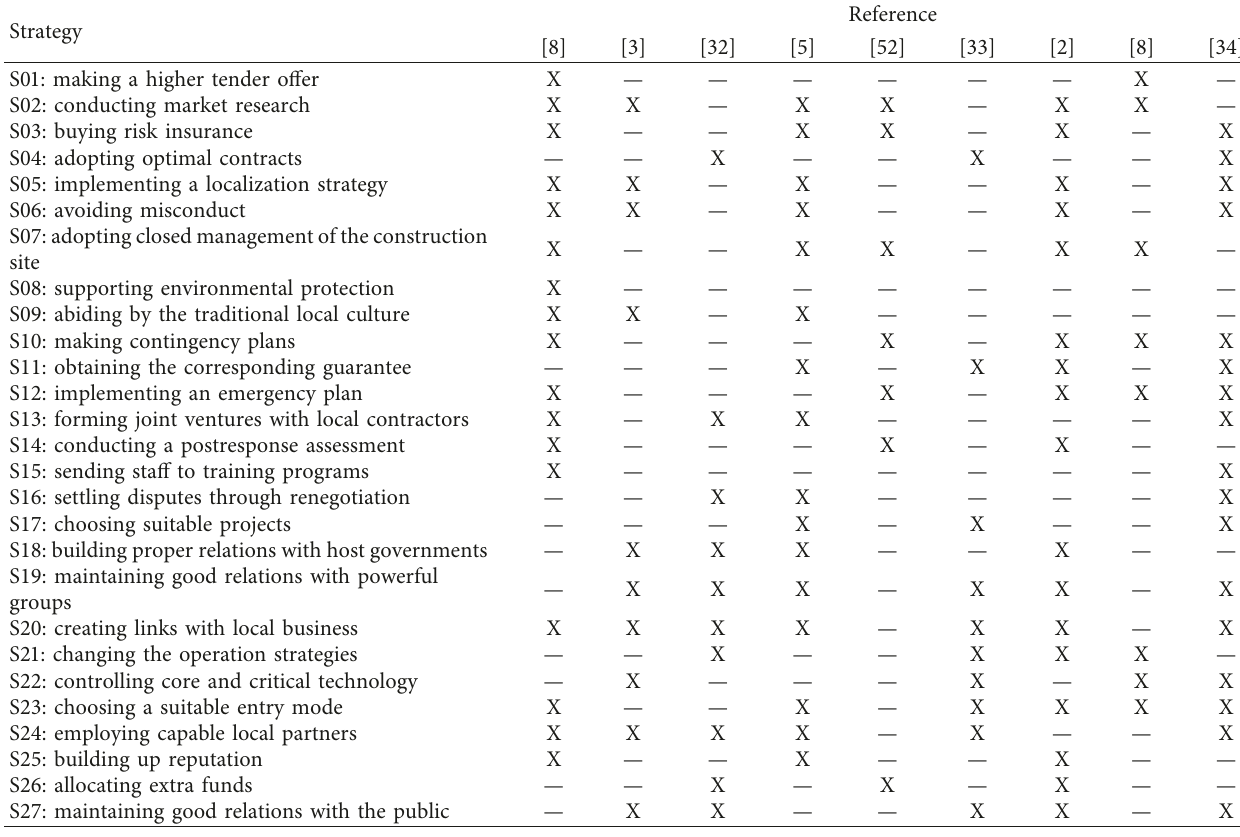
Table 1: Political risk management